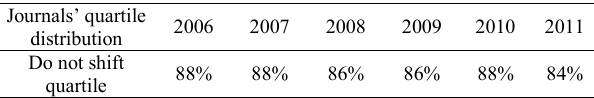
Table 4. Percentage of zoology journals in Sample 1 that